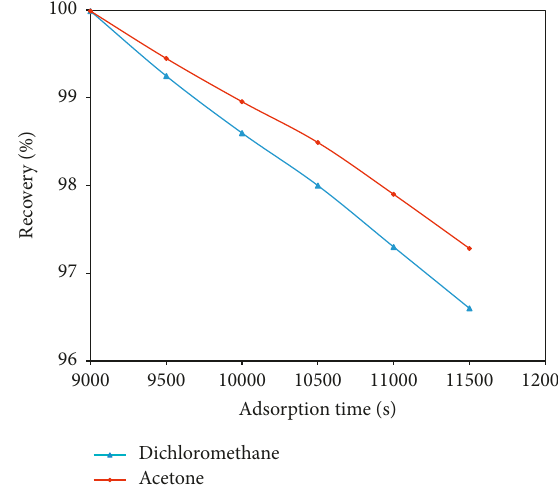
Figure 13: Recovery of dichloromethane and acetone with the adsorption step